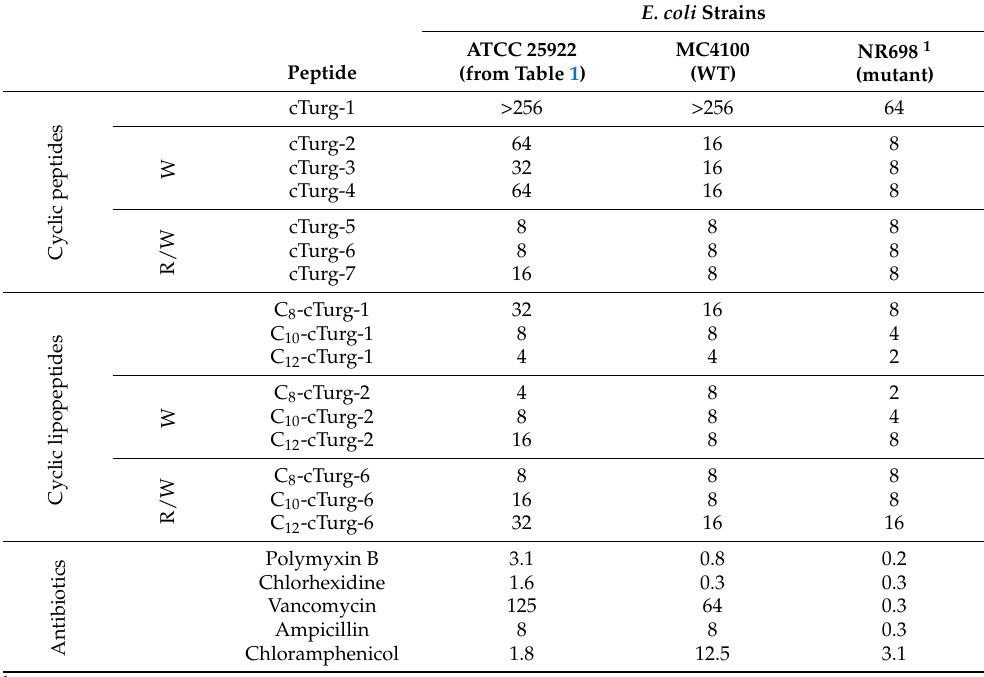
Table 2. Antimicrobial activity (MIC in µ g/mL) of cyclic peptides and selected antibiotics against three strains of E. coli for investigation of effects concerning outer membrane permeability. In addition to the laboratory strain E. coli ATCC 25922, the activity against E. coli MC4100 (wild type, WT) and the outer membrane permeable mutant E. coli NR698 was measured and